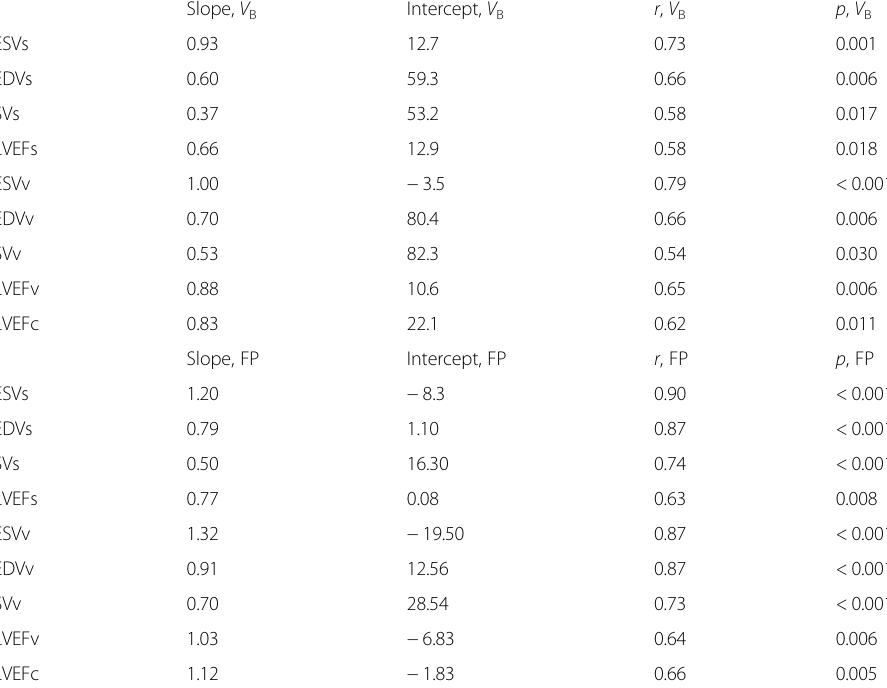
Results excluding outliers are shown in Table 5. Using V parameters except EDVs differed significantly from MRI, as did EDVv and SVv which were significantly overestimated. Using FP images, all surface-based parameters were significantly different from MRI, whereas no significant difference was found for any volume-based parameter.